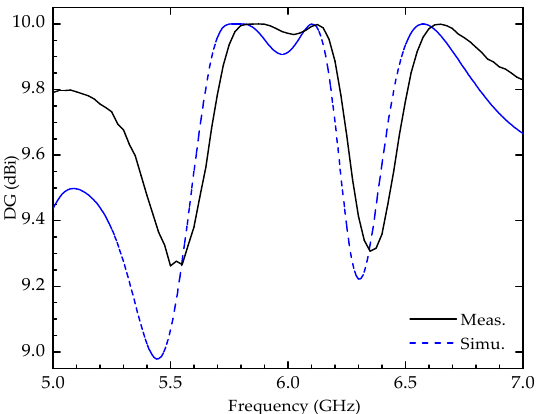
Figure 15. Comparison of measurement and simulation by diversity gain.